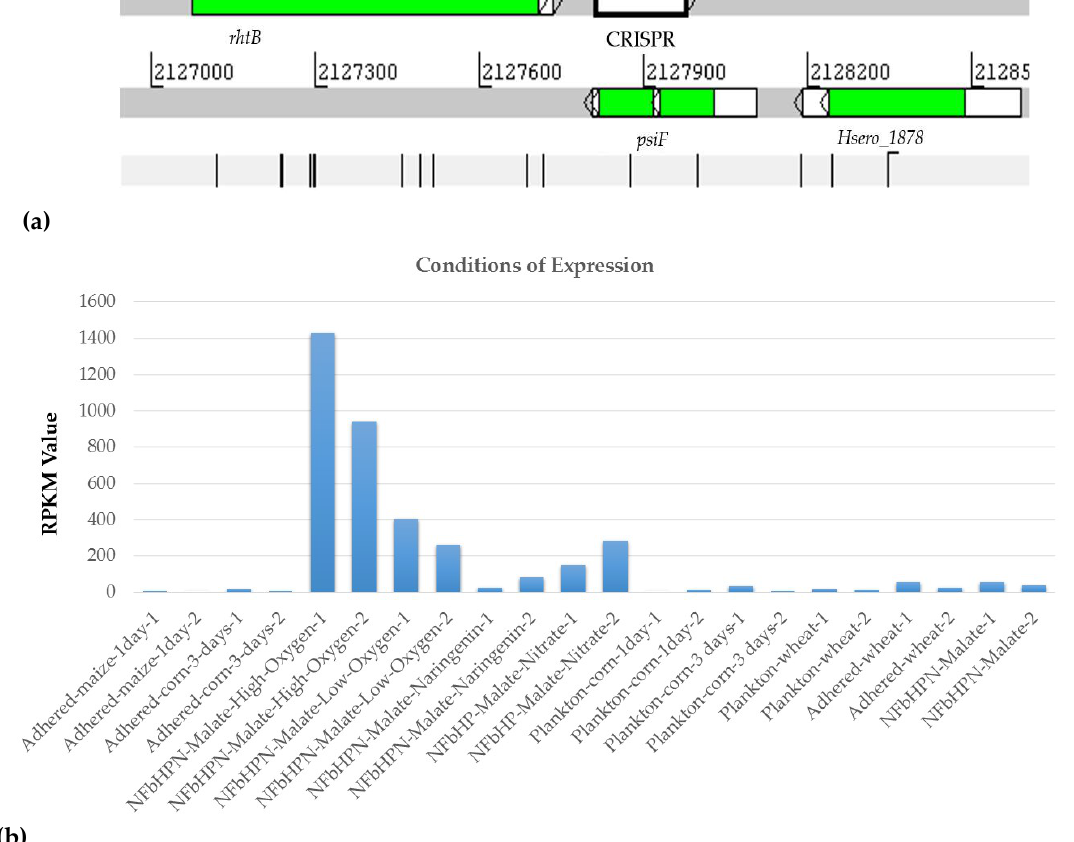
Figure 13. Visualization of the position of CRISPR in the genome of H. seropedicae SmR1 ( a ). Visualization of expression levels of CRISPR in RNA-seq assays in H. seropedicae SmR1. In the colored section, the 11 analyzed experimental conditions are represented, where 1 and 2 represent d.a.i (days after inoculation); ( b ) the numbers represent the value of the gene expression in RPKM.